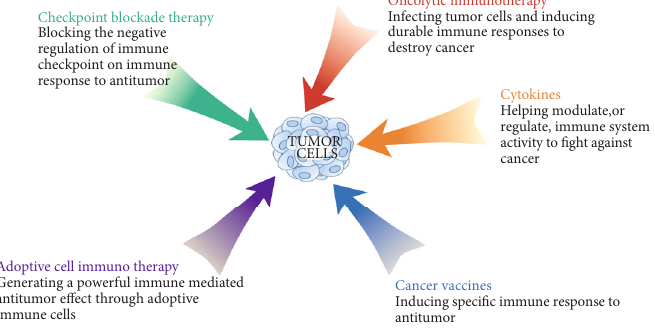
Figure 1: Components and brief mechanisms of cancer